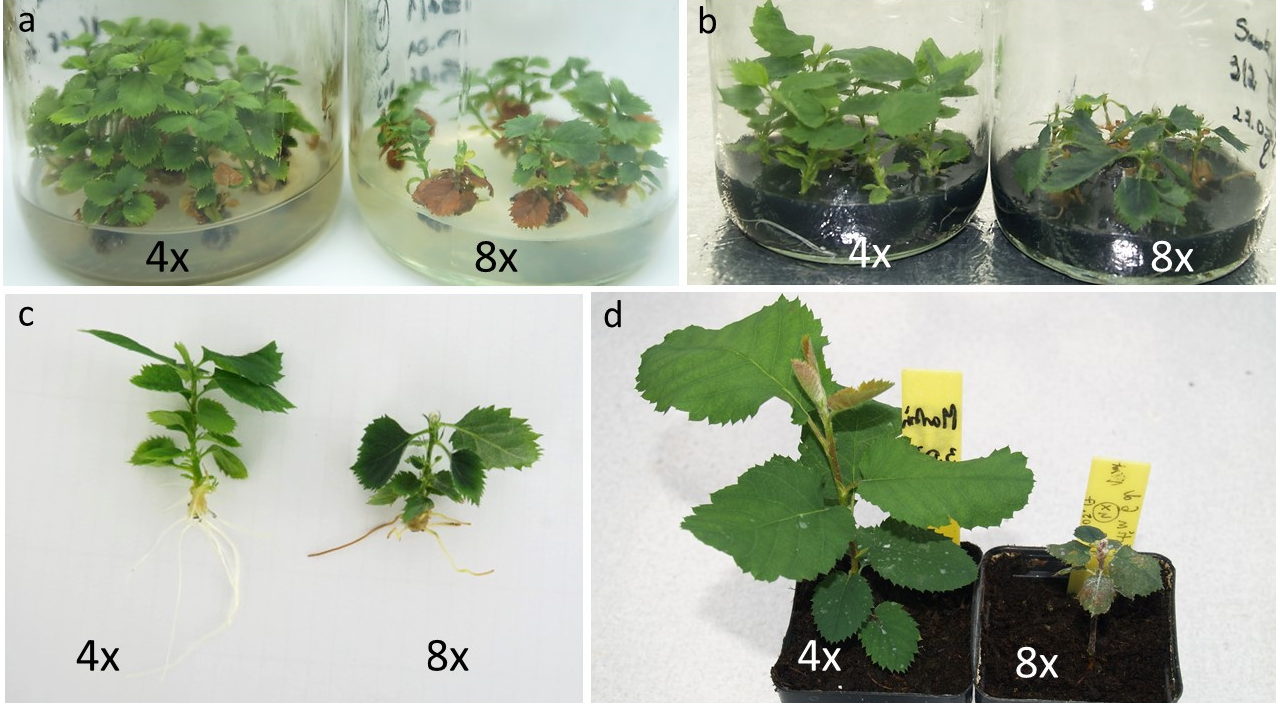
Figure 2. In vitro propagation and rooting of octoploids ( a ) In vitro shoot multiplication of ‘Martin’. ( b ) In vitro shoot rooting of ‘Martin’. ( c ) In vitro rooted shoots (4x was about 3 cm, 8x was about 1.5 cm long). ( d ) Acclimatization of the Saskatoon berry ‘Martin’.